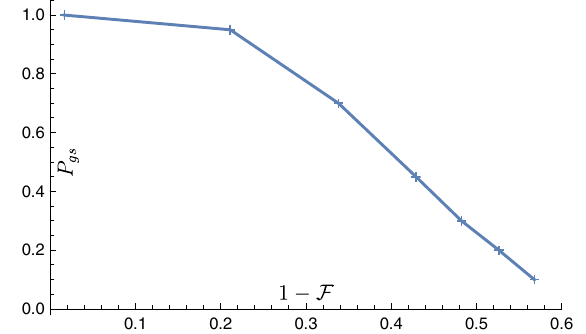
FIG. 9. Probability P as the proportion of 20 runs where gs CoVaR converges to the ground state of the spin chain as a function of starting infidelity from the ground state. While here we report only the probability of converging to the ground state specifically, we note that 97.1% of all runs converge to one of the low-energy eigenstates — the distribution of eigenstates found is detailed in Appendix D 3. Initialization is done the same way as in Fig. 8 by running imaginary time evolution from a random initial state until reaching selected energies between − 5 . 8 and the ground state. A linear decay of success probability — reminiscent of phase-estimation protocols — with ground-state overlap is found, although we expect the rate of this decay to strongly depend on the population distribution of the lowest-energy